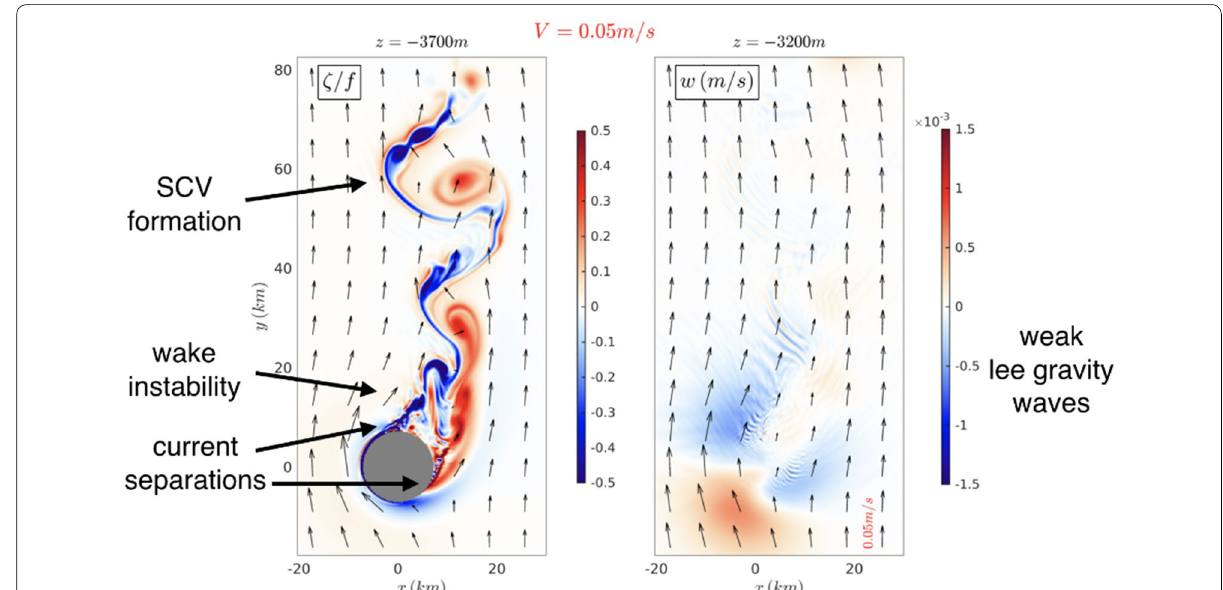
Fig. 16 Seamount wake. Snapshots of normalized vertical vorticity (left) and w (right) in horizontal planes for a simulated flow past a seamount. The upstream flow is steady and uniform, with V = 0.05 m/s to the north. The bottom is flat at z = − 4000 m away from the seamount that has a half-width of 10 km and a height of 600 m. Vertical vorticity is generated by drag on the slope (Fig. 15), the flow separates into an unstable wake, and the vortex filaments organize into coherent SCVs. In this instance, there is only weak lee gravity wave generation, as shown by the small w above the top of the seamount (Srinivasan et al. 2019)